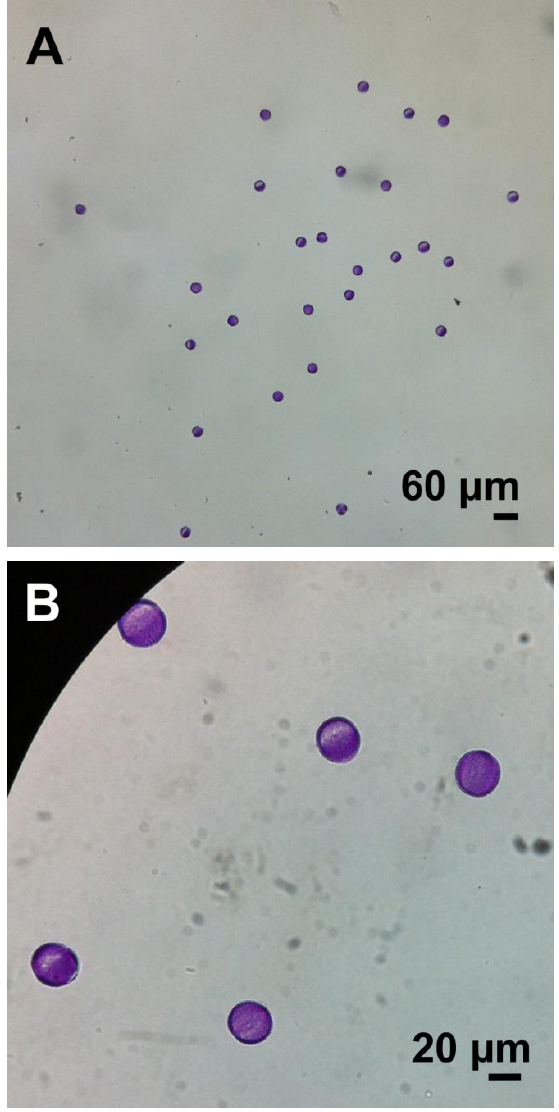
F IGURE 1. Brassica rapa pollen grains in fuchsin gel viewed with light microscopy at (A) 100 × magnification and at (B) 400 ×